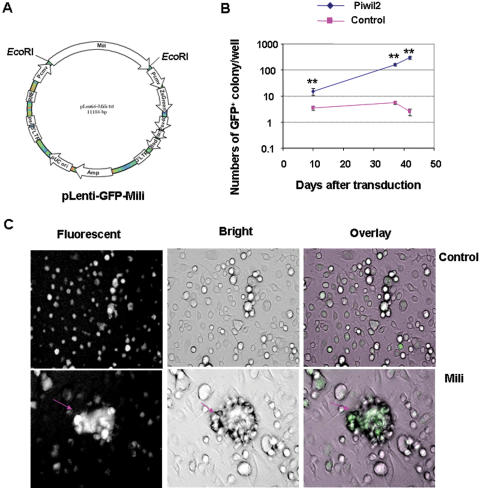
Ectopic expression of mili in BM cells promotes cell proliferation.A. Schematic construct of Lenti-GFP-Mili viral vector. B, The effect of ectopic expression of mili on marrow cell proliferation: BM cells from B6 mice were transduced with Lenti-GFP-Mili or Lenti-GFP viruses in 24-well plates (n = 4 well/group), as described in Methods. The number of GFP+ colonies were counted at indicated times. **, p<0.01, compared to Lenti-GFP group. C, Representative eGFP+ EB-like colonies at day 10 post transduction (arrow). The micrographs were taken under the inverted fluorescent microscope (Nikon, TE2000-U, Japan), using original magnification: ×200.